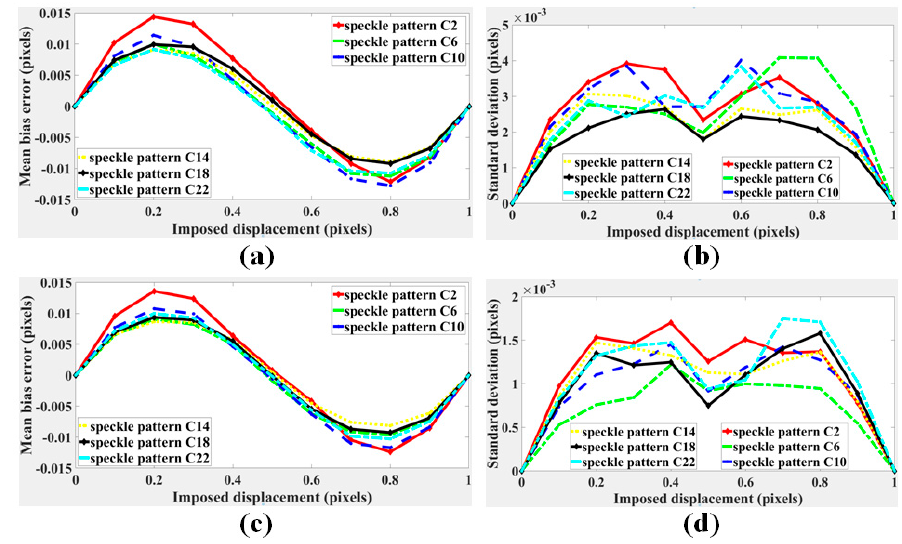
Figure 12. ( a ) Mean bias errors and ( b ) standard deviations of speckle patterns displacements in group C calculated with the subset of 31 × 31 pixels. ( c ) Mean bias errors and ( d ) standard deviations of speckle patterns displacements in group C calculated with the subset of 61 × 61 pixels.